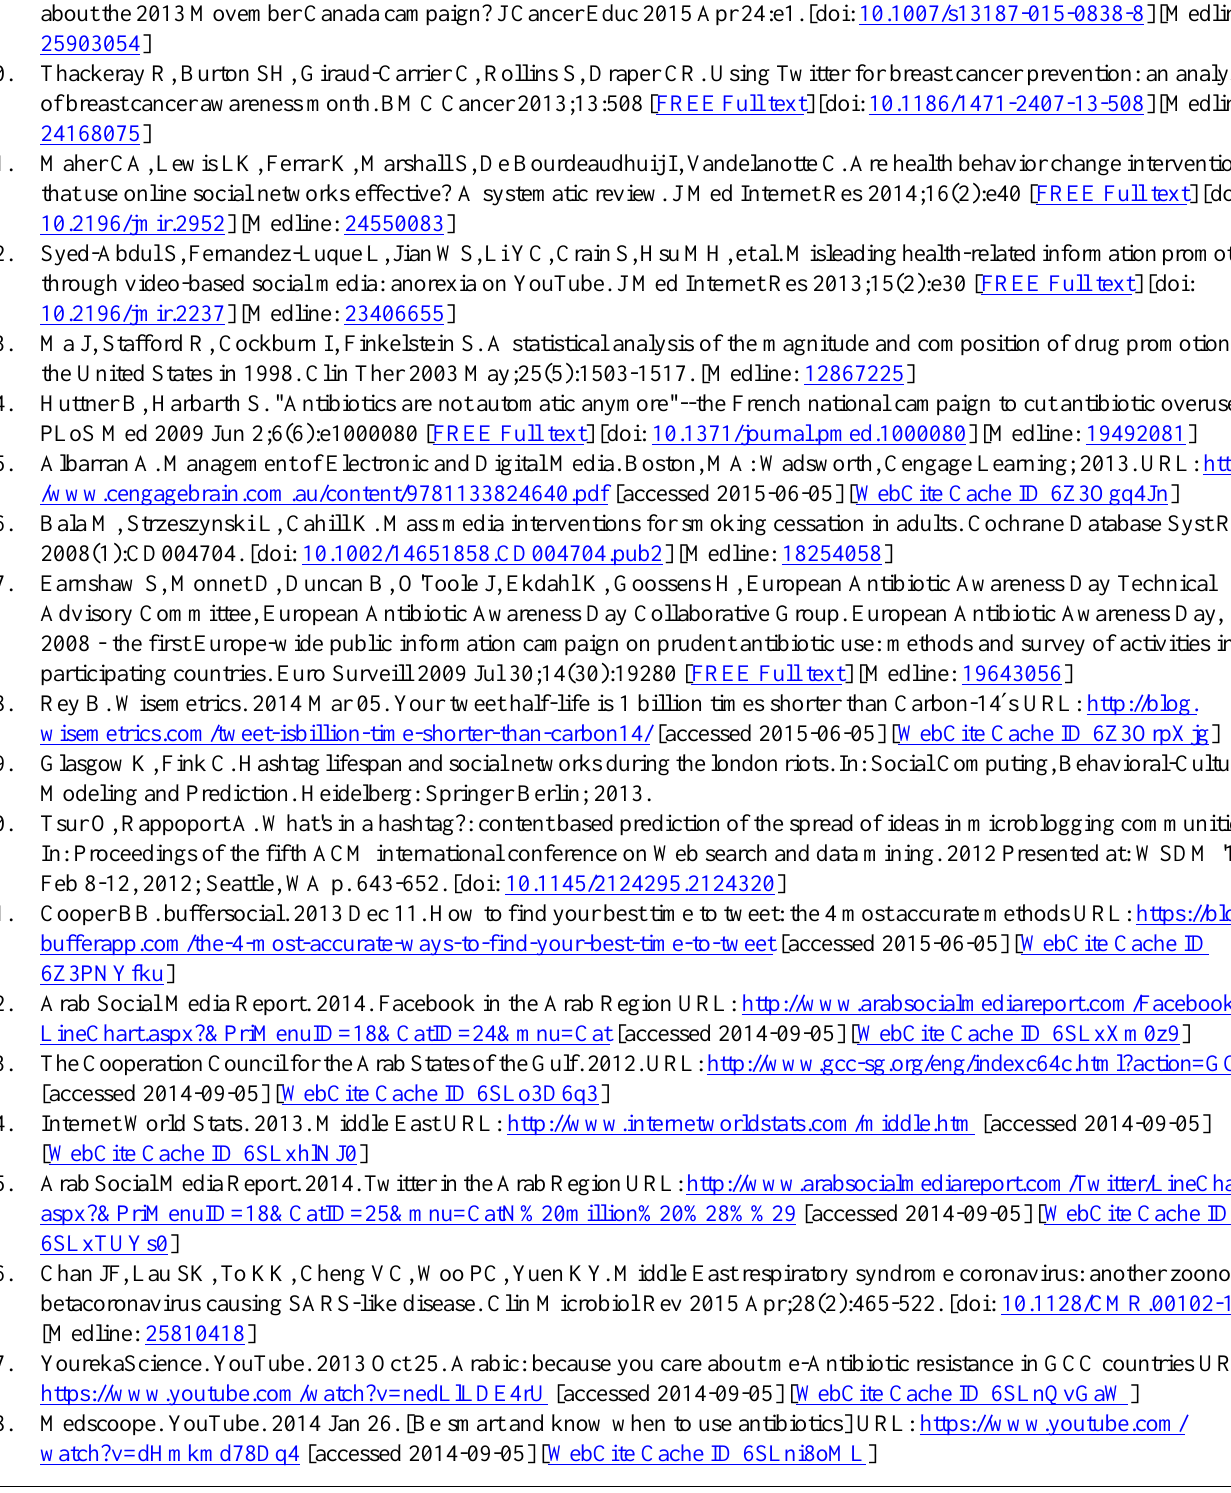
AIDS: acquired immune deficiency